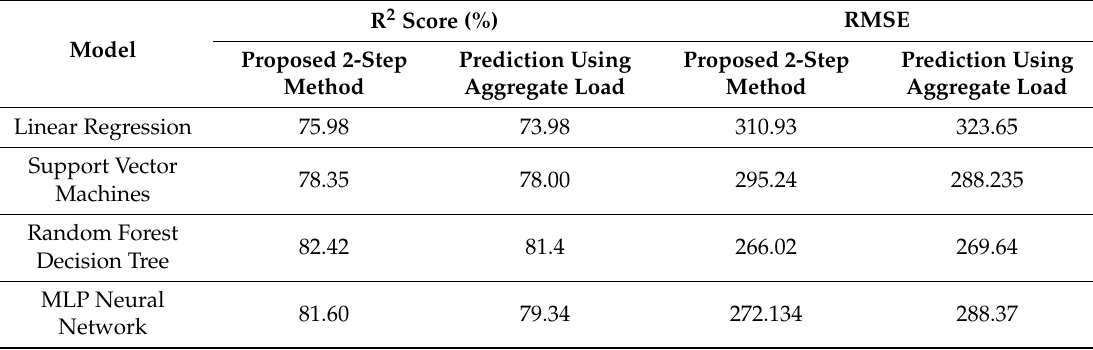
Table 8. Comparison of day-ahead aggregate load prediction through the proposed 2-step method (which includes disaggregation) method and prediction only using the aggregate